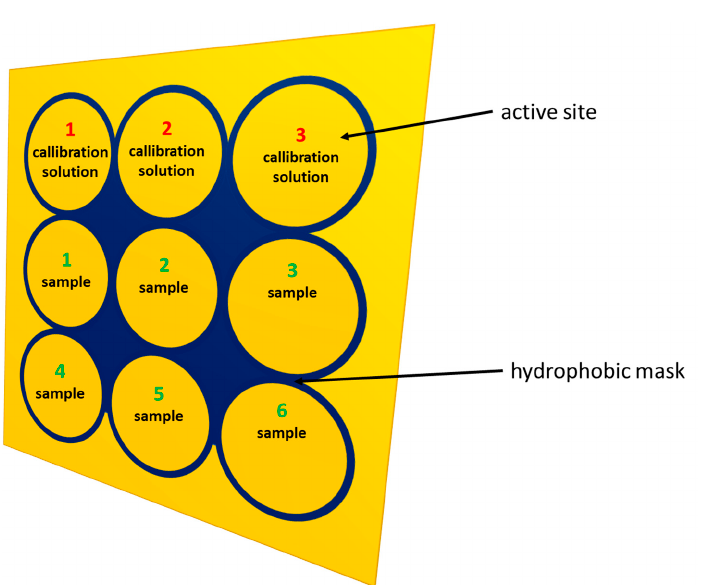
Figure A1. Scheme of biosensors used during the research. Table A1. Detailed data for Figure